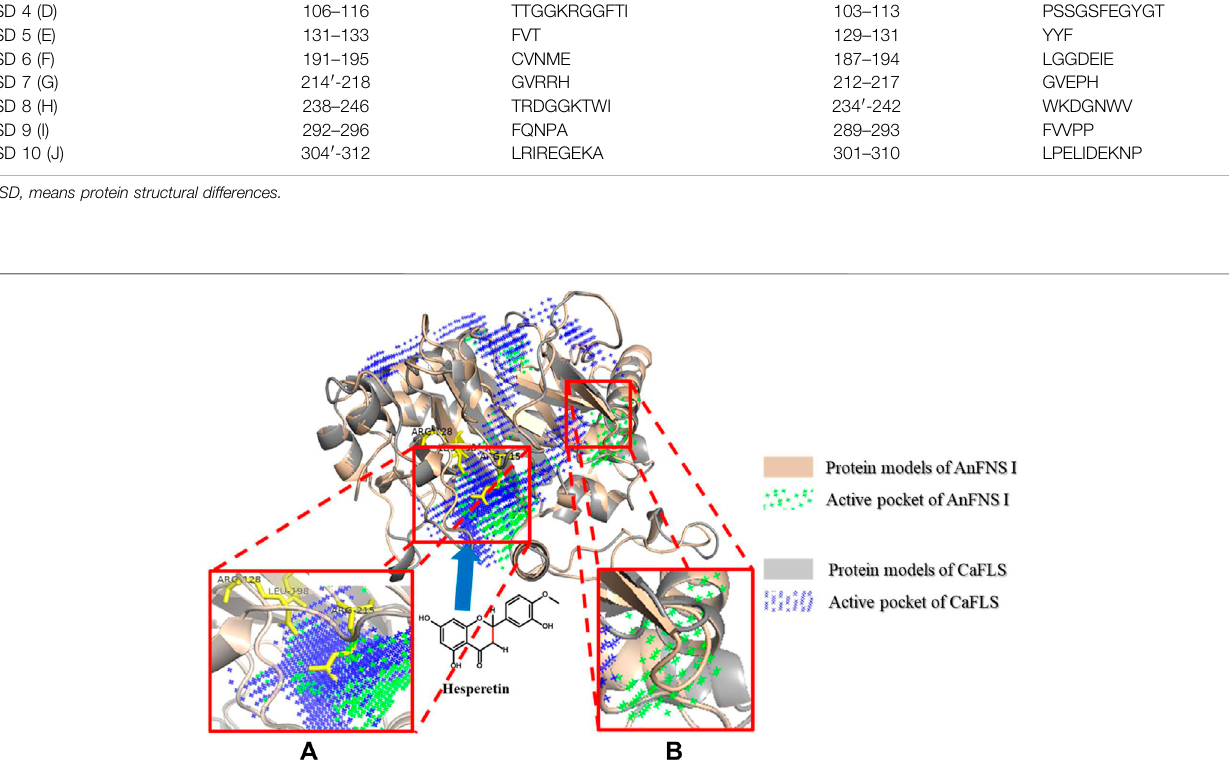
Frontiers in Pharmacology |